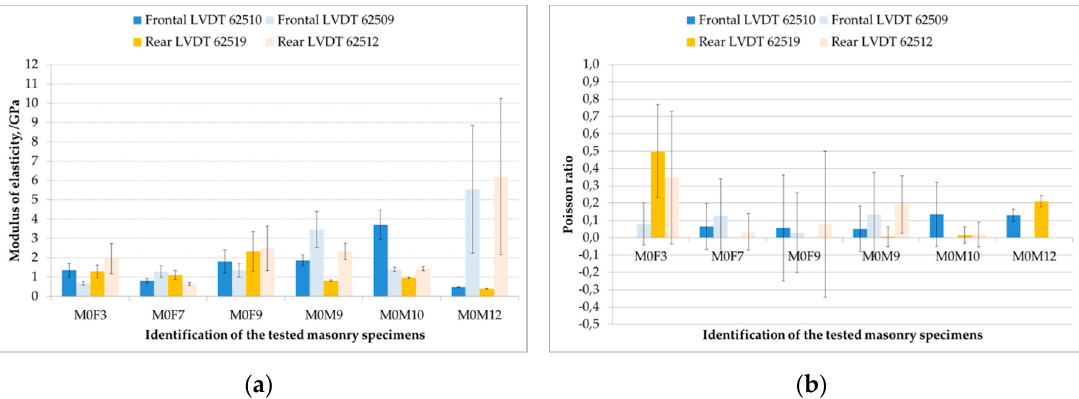
Figure 15. Estimates and standard uncertainties obtained from the contact measurement system for ( a ) the modulus of elasticity; ( b ) and the Poisson ratio.